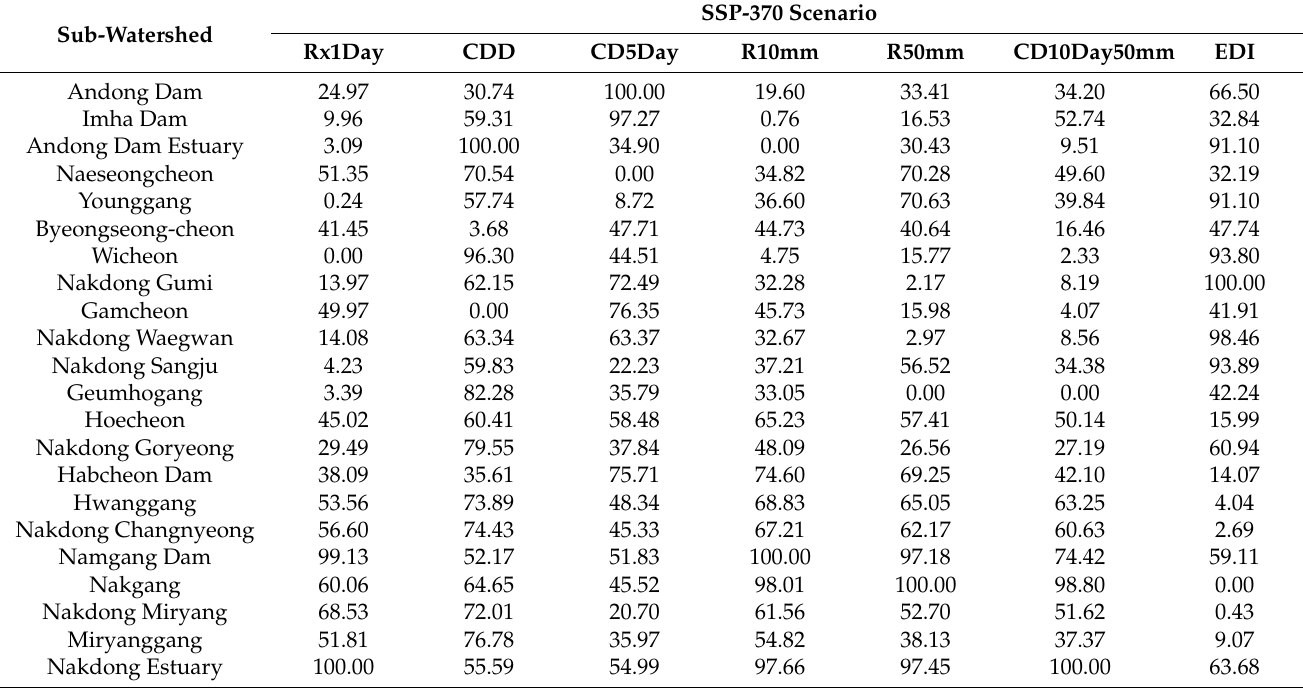
Table 7. Standardized indices of climate change exposure in scenario SSP-370.